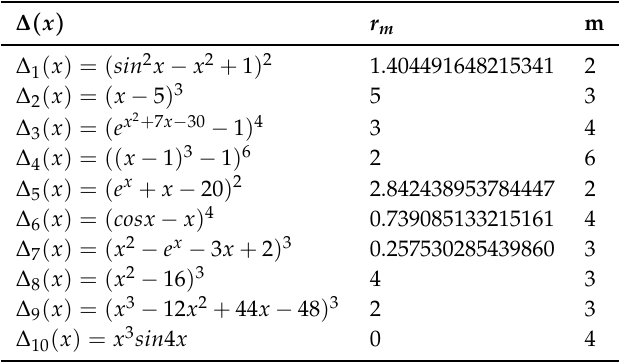
Table 1. A collection of nonlinear univariate